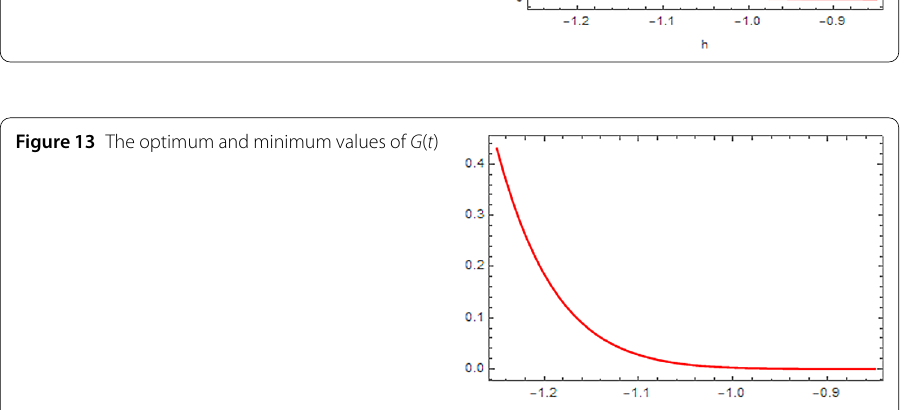
solution for nonlinear differential equations and obtain approximate semianalytic solu- tions. In this manner, HAM is very effective and powerful technique to find the solu-